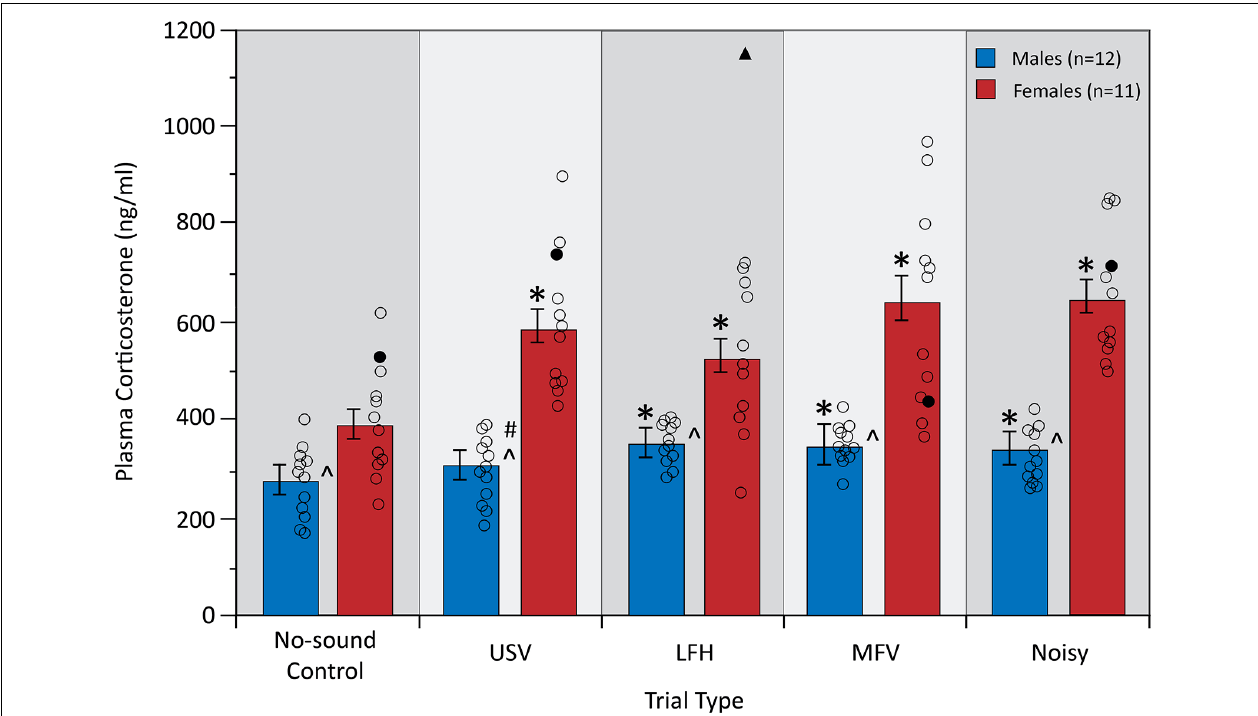
FIGURE 4 | Plasma corticosterone levels in response to vocalization playback. All vocalization categories increased corticosterone in females, but only non-USV categories increased corticosterone in males. Females had a greater plasma corticosterone concentration than males across trials, and the magnitude of increase was greater in females than in males. Error bars represent standard error of the mean (SEM). Symbols for Figures 4 – 7: ∗ differs from no-sound control, p < 0.05; ∧ differs between sexes, p < 0.0125; # interaction between sex and trial type, p < 0.0125; unfilled black circles represent individual data points for males and females. Black triangle indicates an outlier data point from one animal that was removed from this analysis; filled black circles represent non-outlier data from the same animal that was also removed due to the repeated measures